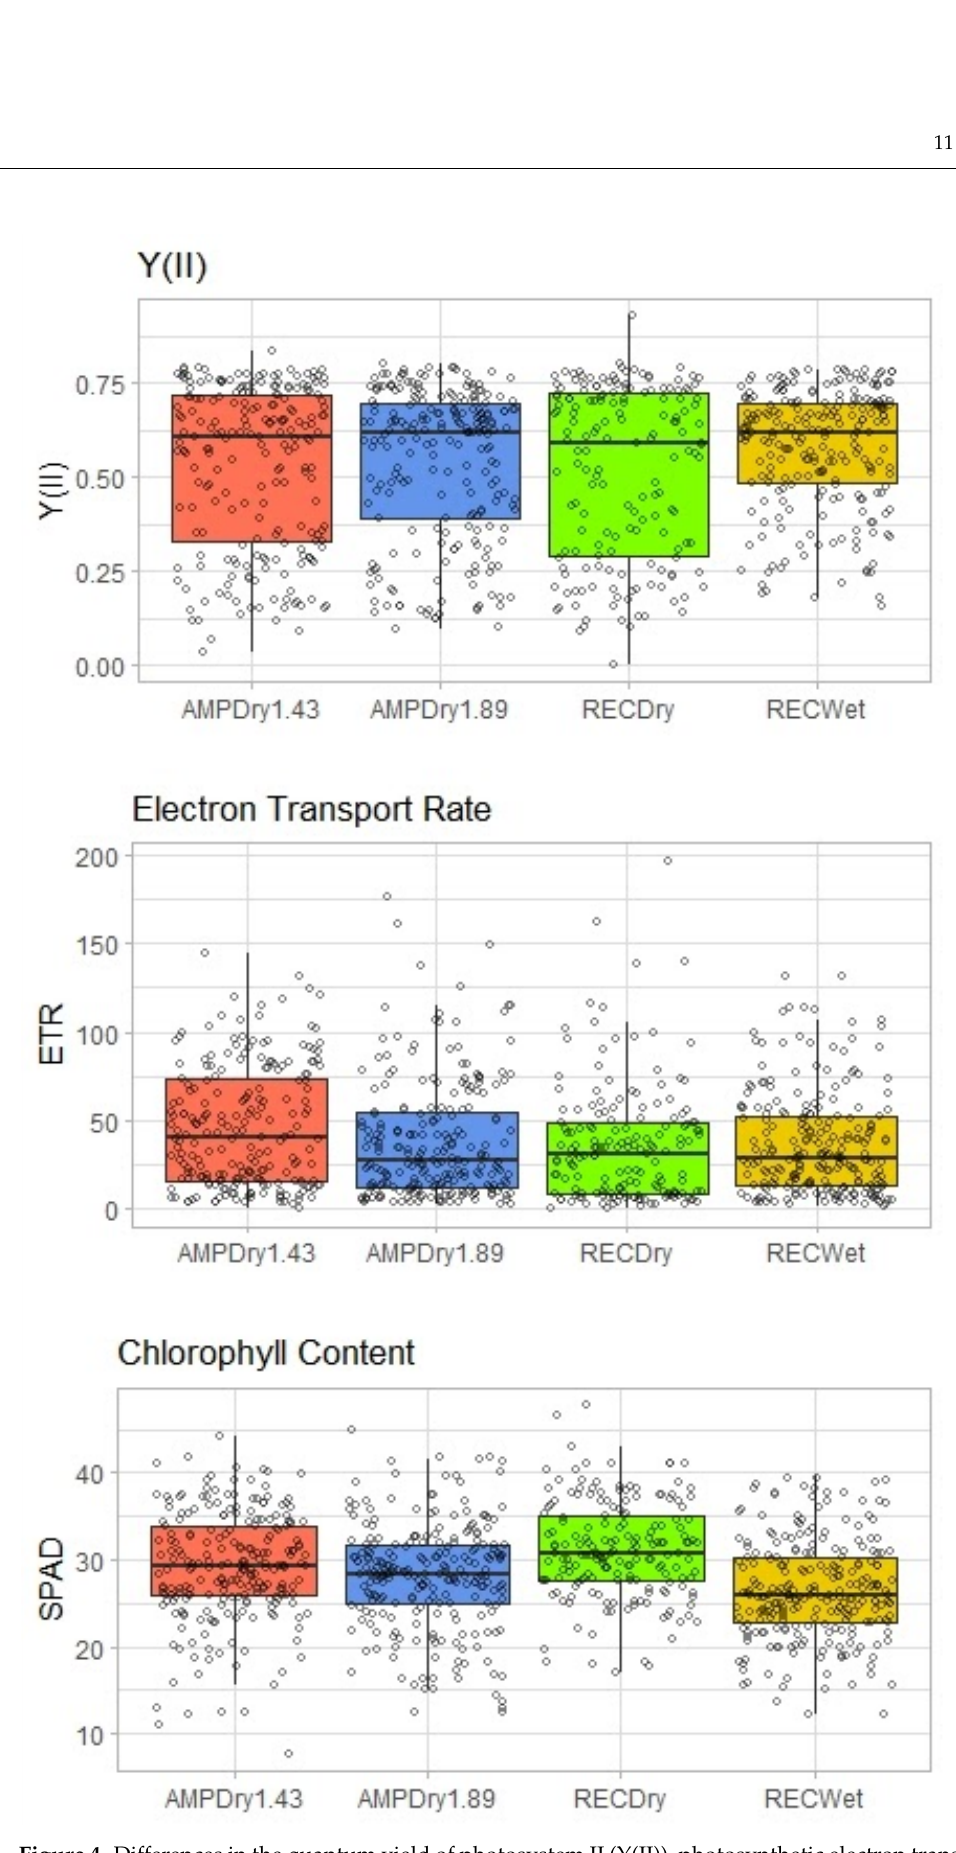
Figure 4. Differences in the quantum yield of photosystem II (Y(II)), photosynthetic electron transport rate (ETR) and chlorophyll concentration of leaves (SPAD unit), assessed by treatment across the experimental period.